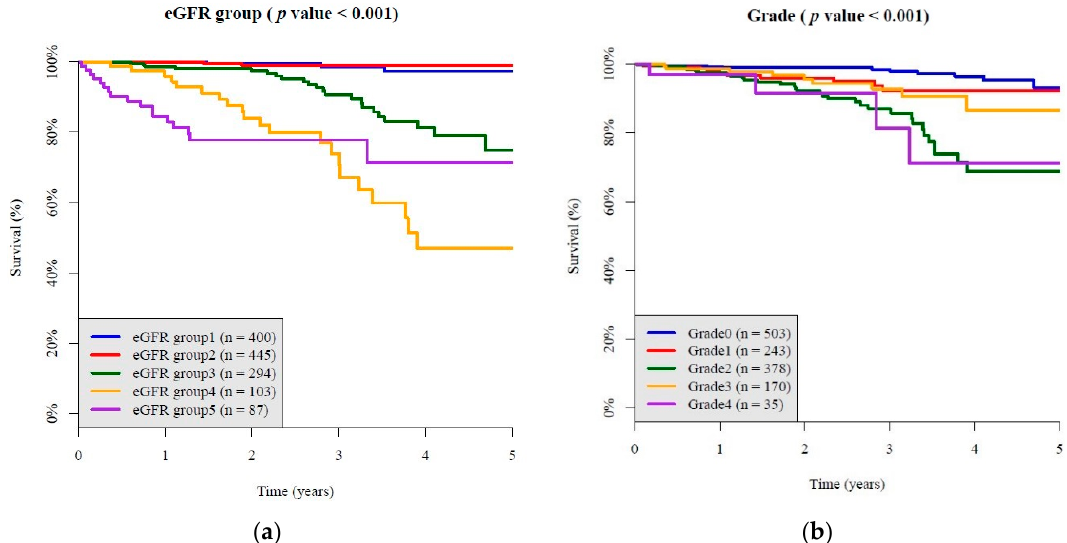
Figure 2. The Kaplan–Meier survival curve showed progression of diabetic retinopathy comparison in each grade and different tertiles of baseline HbA1C. ( a ) A stepwise fashion of ESRD incidence in all enrolled participants with different initial grade of diabetic nephropathy; ( b ) a stepwise fashion of ESRD incidence in all enrolled participants, from mild NPDR to moderate NPDR, to severe NPDR, to PDR.